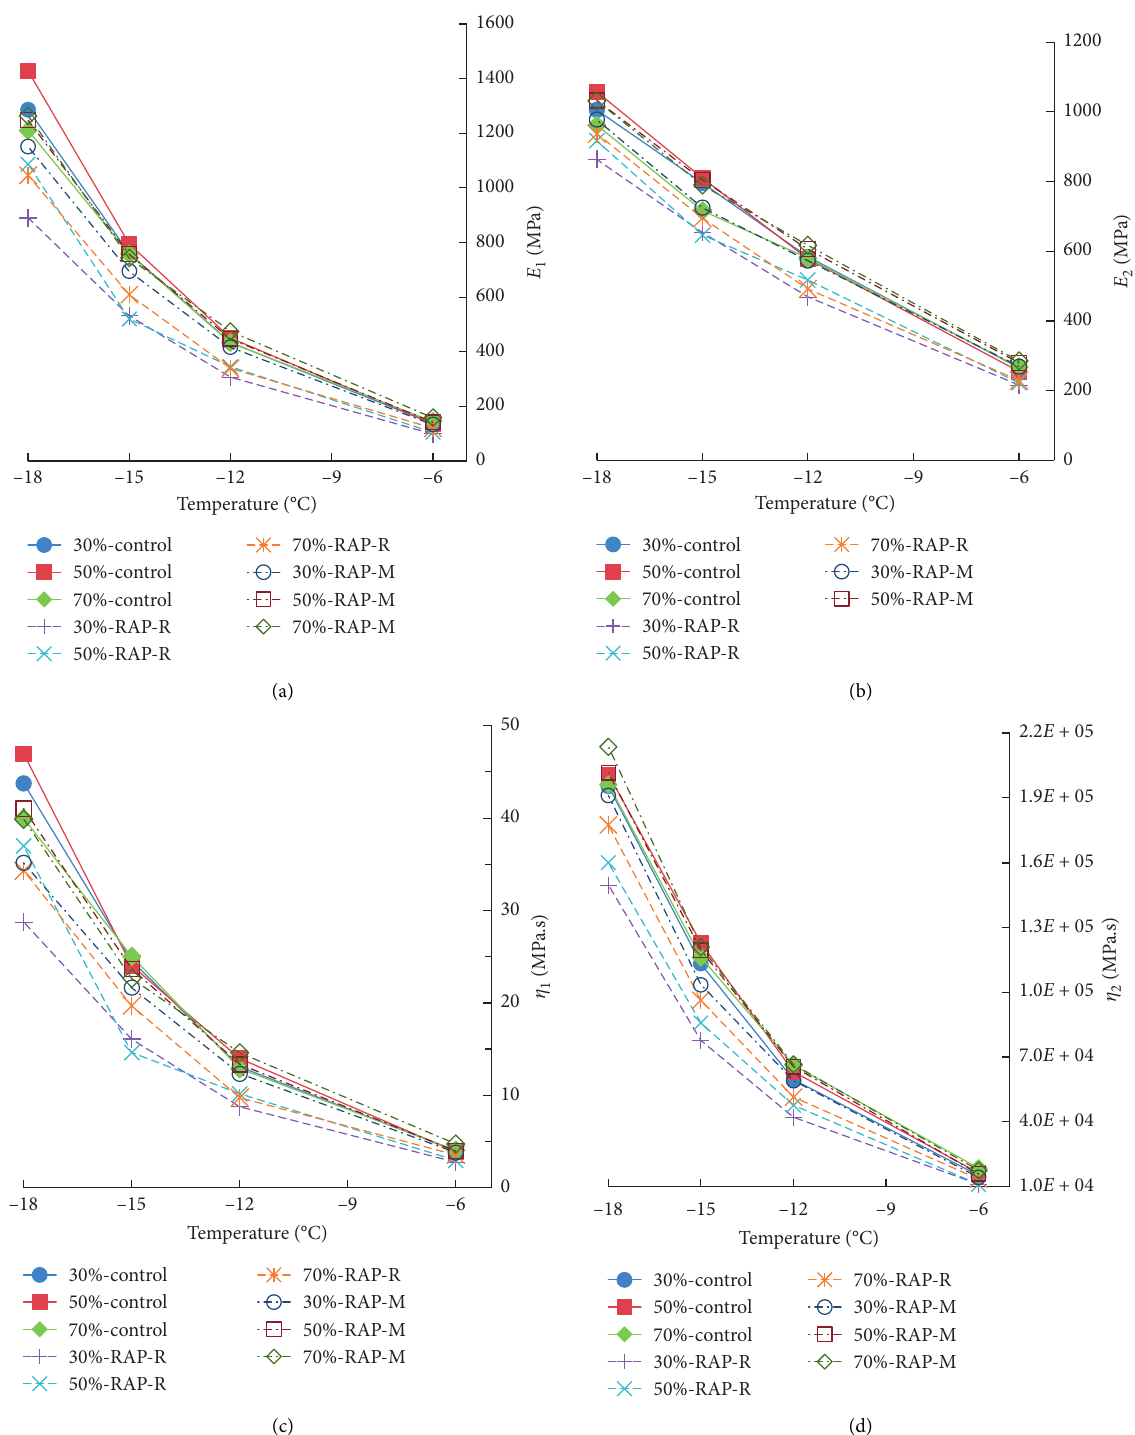
Figure 15: Parameters of Burgers’ model for WMRA binders at various temperatures. (a) Delayed elastic parameter E . (c) Delayed viscous parameter η parameter E 2